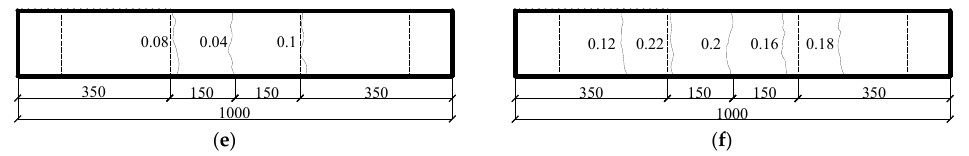
Figure 4. Specific location of cracks on the tensile surface (all crack widths used in this paper were the